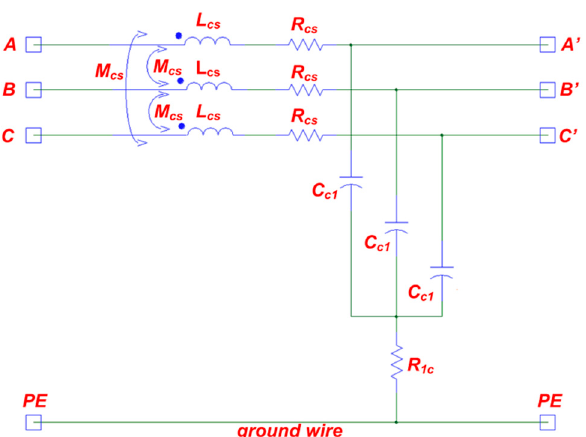
Figure 10. A model of cable.